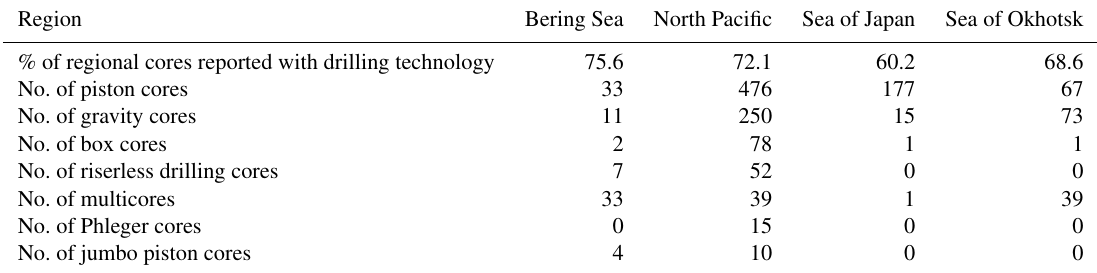
∗ These cores are listed in large data tables in auxiliary publications, but the original reporting is not publicly available. Table 2. Percent of regional cores reported with coring technology and the number of cores recovered in the North Pacific and marginal seas by coring technology. Additional reported coring technologies include the less often utilized hydrostatic cores, kasten cores, Asura cores, pressure cores, and trigger